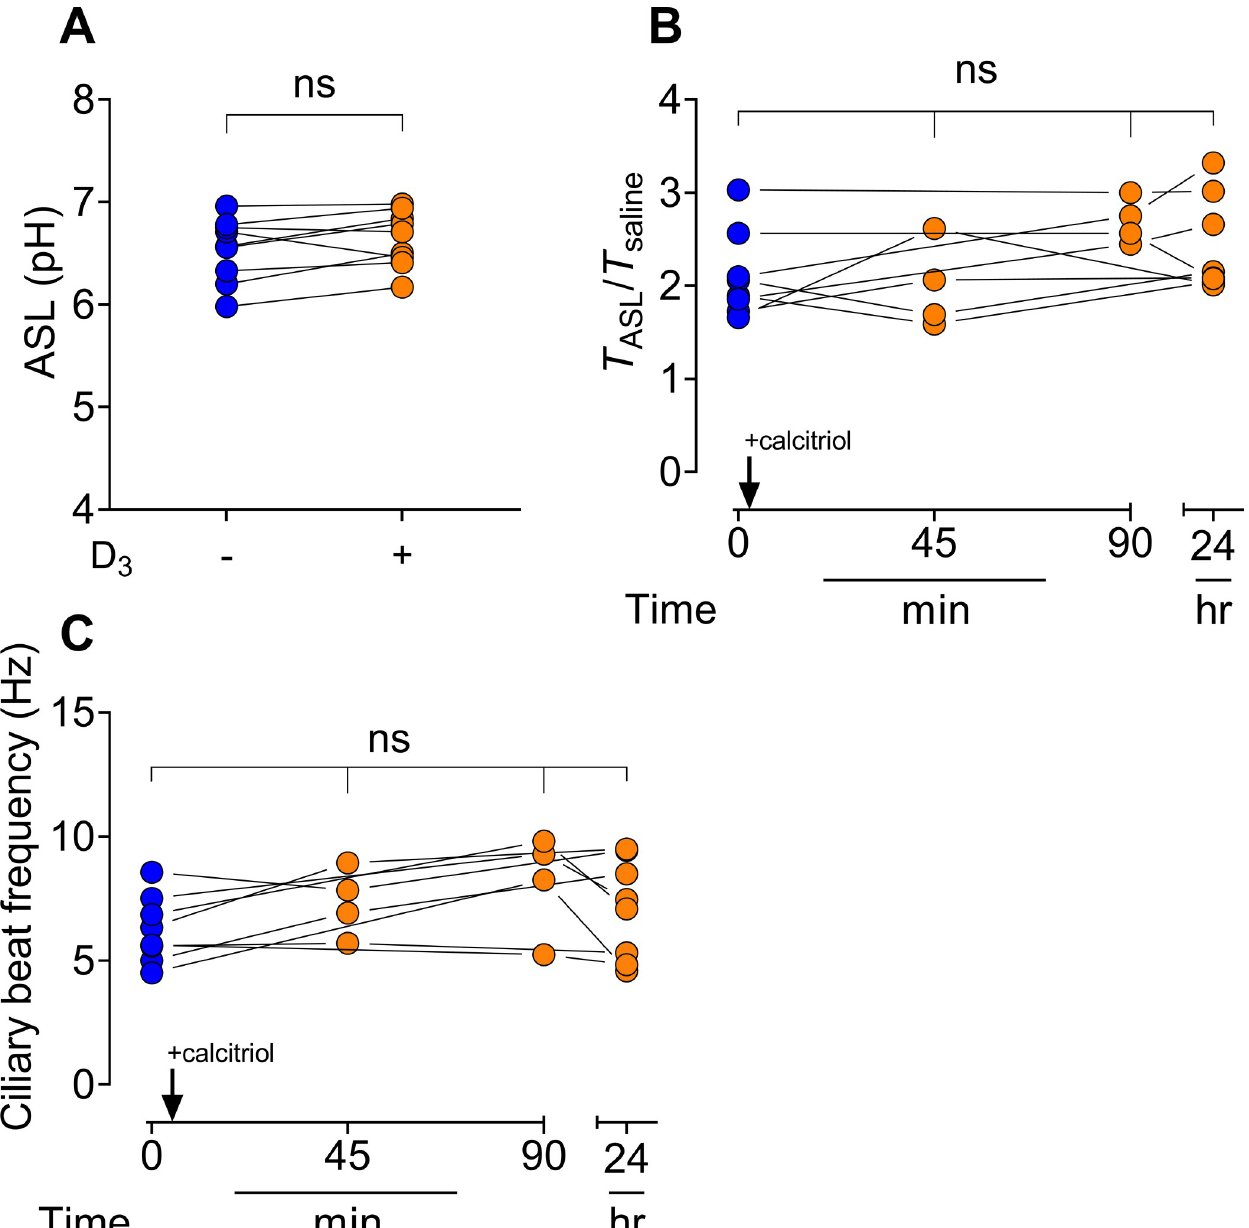
Fig 2. ASL pH and viscosity from hAECs treated without and with calcitriol. A. Calcitriol free and supplemented basolateral hAEC media (n = 9 donors) was changed when apical saline+1mM HEPES solution was applied; after 22h ASL was collected, and pH read. Significance determined by paired t -test, p = 0.11. B. FITC-D within ASL ( � 12h) was excited (488 nm), baseline images were acquired then a small circular region (radius 5.2 μ m) was photobleached and fluorescent recovery monitored for > 1 min; recovery was compared to FITC-D in PBS. Significance determined by one-way ANOVA with Sˇı´da´k’s multiple comparisons test, 0 vs. 45 min p = 0.98, 0 vs. 90 min p = 0.20, 0 vs. 24h, p = 0.36. C. Time-course of paired (n = 4 or n = 8 per timepoint) hAEC CBF acquired using brightfield imaging before (0 min) and after 100 nM basolateral calcitriol supplementation, significance determined by one-way ANOVA with Sˇı´da´k’s multiple comparisons test, 0 vs. 45 min p = 0.40, 0 vs. 90 min p = 0.20, 0 vs. 24h, p =